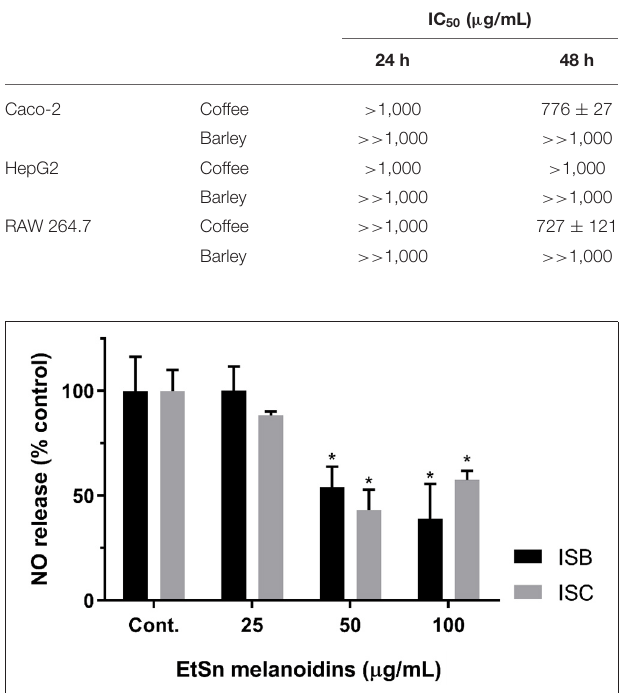
FIGURE 3 | Anti-inflammatory potential of ISC and ISB EtSn melanoidins. RAW 264.7 cells were exposed to different concentrations of ISB (black bars) and of ISC (grey bars) EtSn melanoidins (0, 25, 50, and 100 µ g/mL) in the presence of LPS (1 µ g/mL), please see methods for details. The supernatant was collected 24h later and NO production was assayed using the Griess reagent. Results are expressed as percentage of control (LPS exposed cells) and data represent mean ± S.D. ( n = 3 independent experiments, each one with 4 replicates). (*) denotes statistical differences, comparing to respective control.